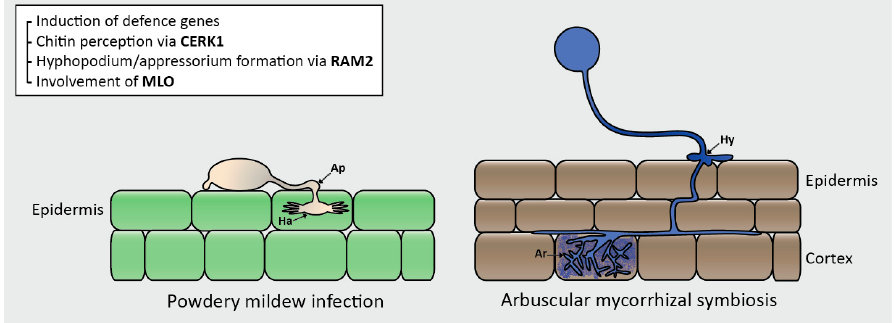
Figure 2. An example of the physical and genetic similarities between infection by a biotrophic pathogen, powdery mildew, and colonisation by AMF. These similarities are predicted to be central to potential trade-offs. During powdery mildew infection, a spore lands on the leaf surface and germinates, forming a primary germ tube. An appressorium (Ap) is then formed which produces a penetration peg and permeates the leaf surface. Inside the epidermal cells, a haustorium (Ha) develops. During AM colonization, a spore germinates and forms an extracellular hypha which travels towards the root surface and a hyphopodium (Hy) is formed. The AM hypha travels through the epidermal cell layer to the mesodermis where it grows between the cells. Upon reaching the inner cortex, the hyphae spread laterally, entering cortical cells and branching repeatedly to form arbuscules (Ar). Common genes and defence programmes (shown in text box) are also involved in infection by pathogens and colonisation by AMF.